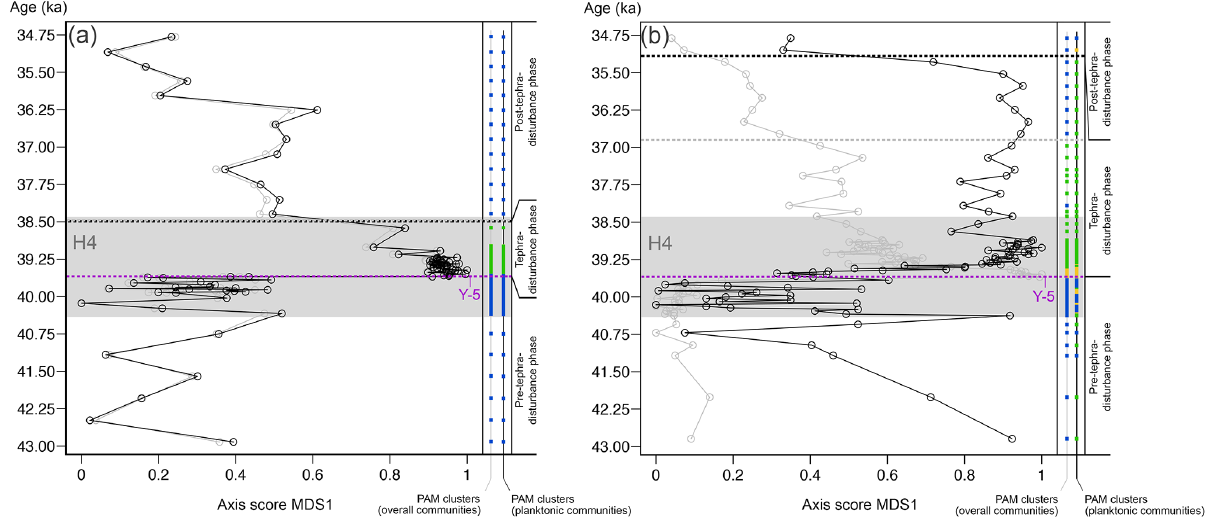
Figure 4. Diagrams showing changes in MDS (multidimensional scaling) diatom community compositions (black curves: planktonic com- munities; grey curves: overall communities) and respective PAM community assignments (colored bars for lakes Ohrid (a) and Prespa (b) . The purple dashed lines indicate the timing of the Y-5 eruption, the grey areas the timing of the H4 event, and the black and grey dashed lines the return of the respective planktonic and overall community compositions to quasi pre-disturbance